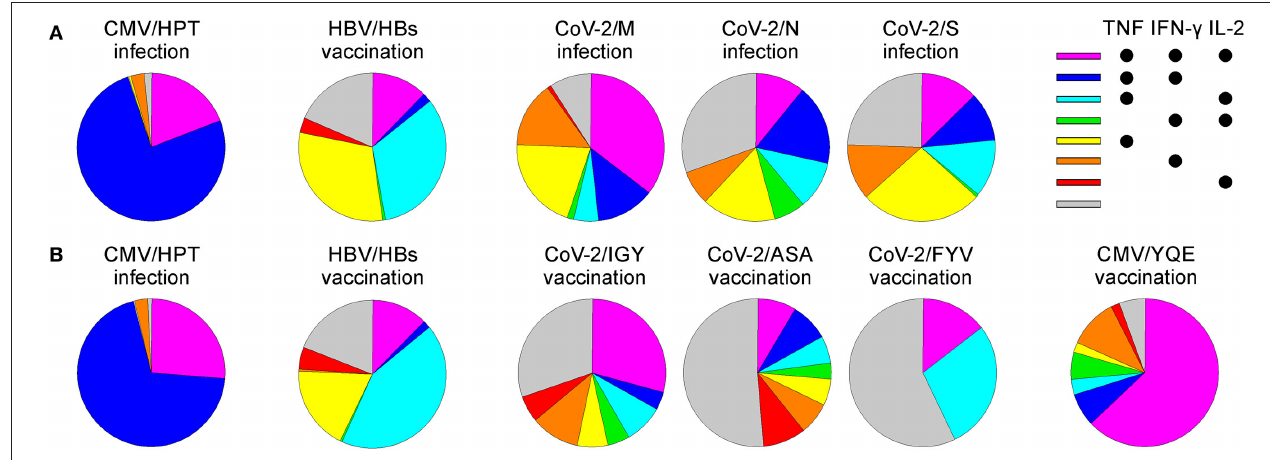
FIGURE 12 | The polyfunctional profile of CD154 + m24 + CD4 + WB T cells for various viruses and vaccination conditions. The pie charts represent the distribution of the cytokine production patterns from the donors and antigens tested in the study after CMV peptide vaccination ( n = 1), CMV infection ( n = 1), CoV-2 infection ( n = 3, mean is represented), CoV-2 peptide vaccination ( n = 1), or HBV vaccination ( n = 2, mean is represented) after 4h (A) or 6h (B) of stimulation with the respective peptides. Samples of the CMV infection and HBV vaccination were stimulated for 4 and 6h for comparative